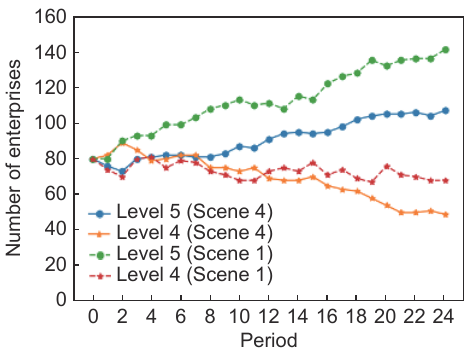
Fig. 13 Scenes 1 and 4: Changes of number of enterprises in Levels 4 and 5.